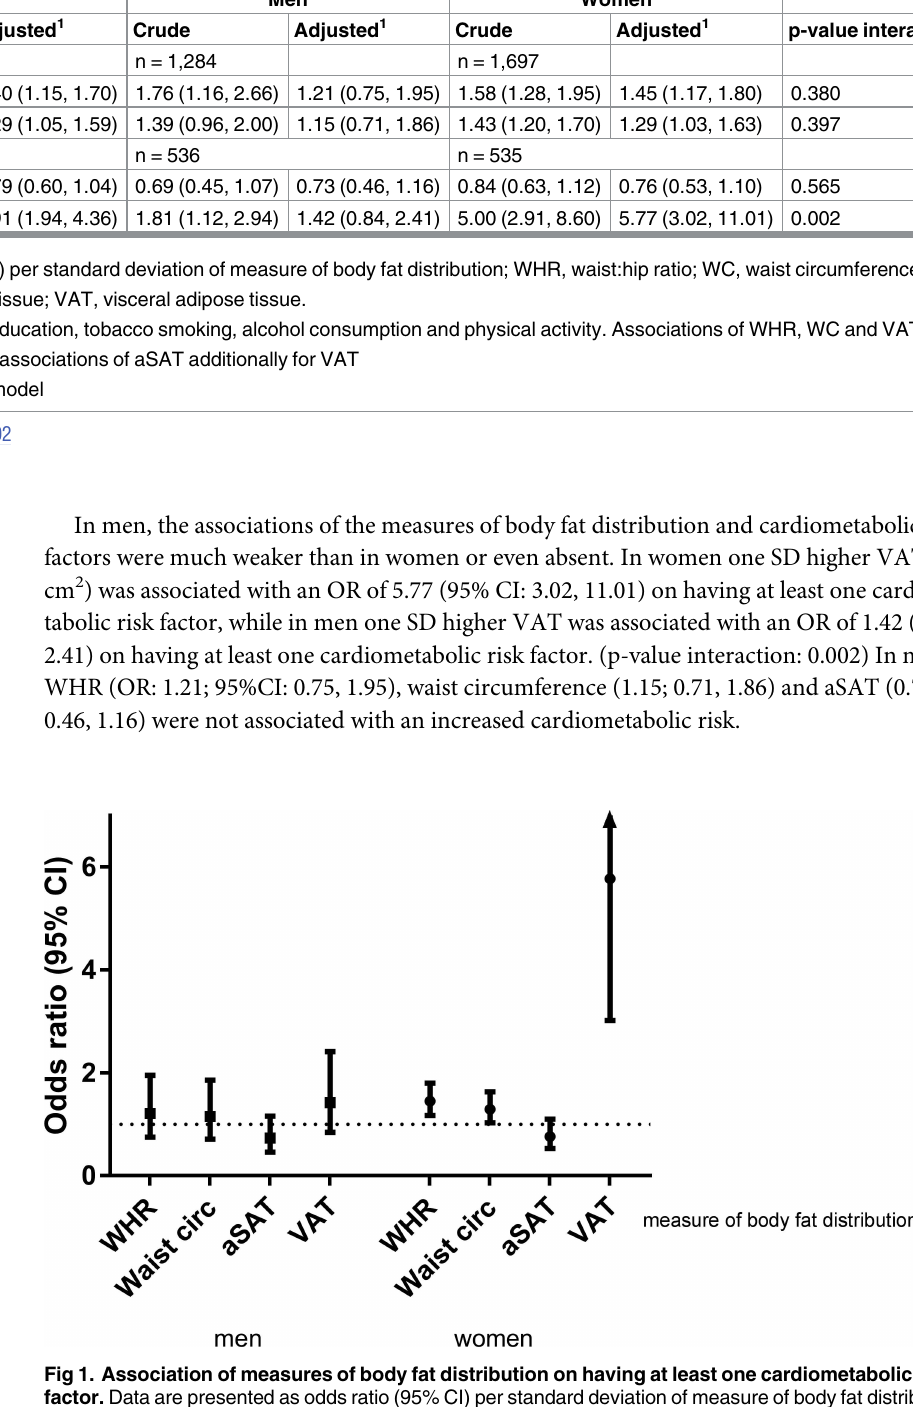
Fig 1. Association of measuresof body fat distribution on having at least one cardiometabolic risk factor. Data are presented as odds ratio (95% CI) per standarddeviationof measureof body fat distribution in men and women. WHR, waist:hip ratio; WC, waist circumference; aSAT, abdominal subcutaneous adipose tissue; VAT, visceral adiposetissue adjusted for age, ethnicity, education,tobacco smoking, alcohol consumption and physicalactivity. Associations of WHR, WC and VAT are additionallyadjustedfor total body fat and associationsof aSAT additionallyfor